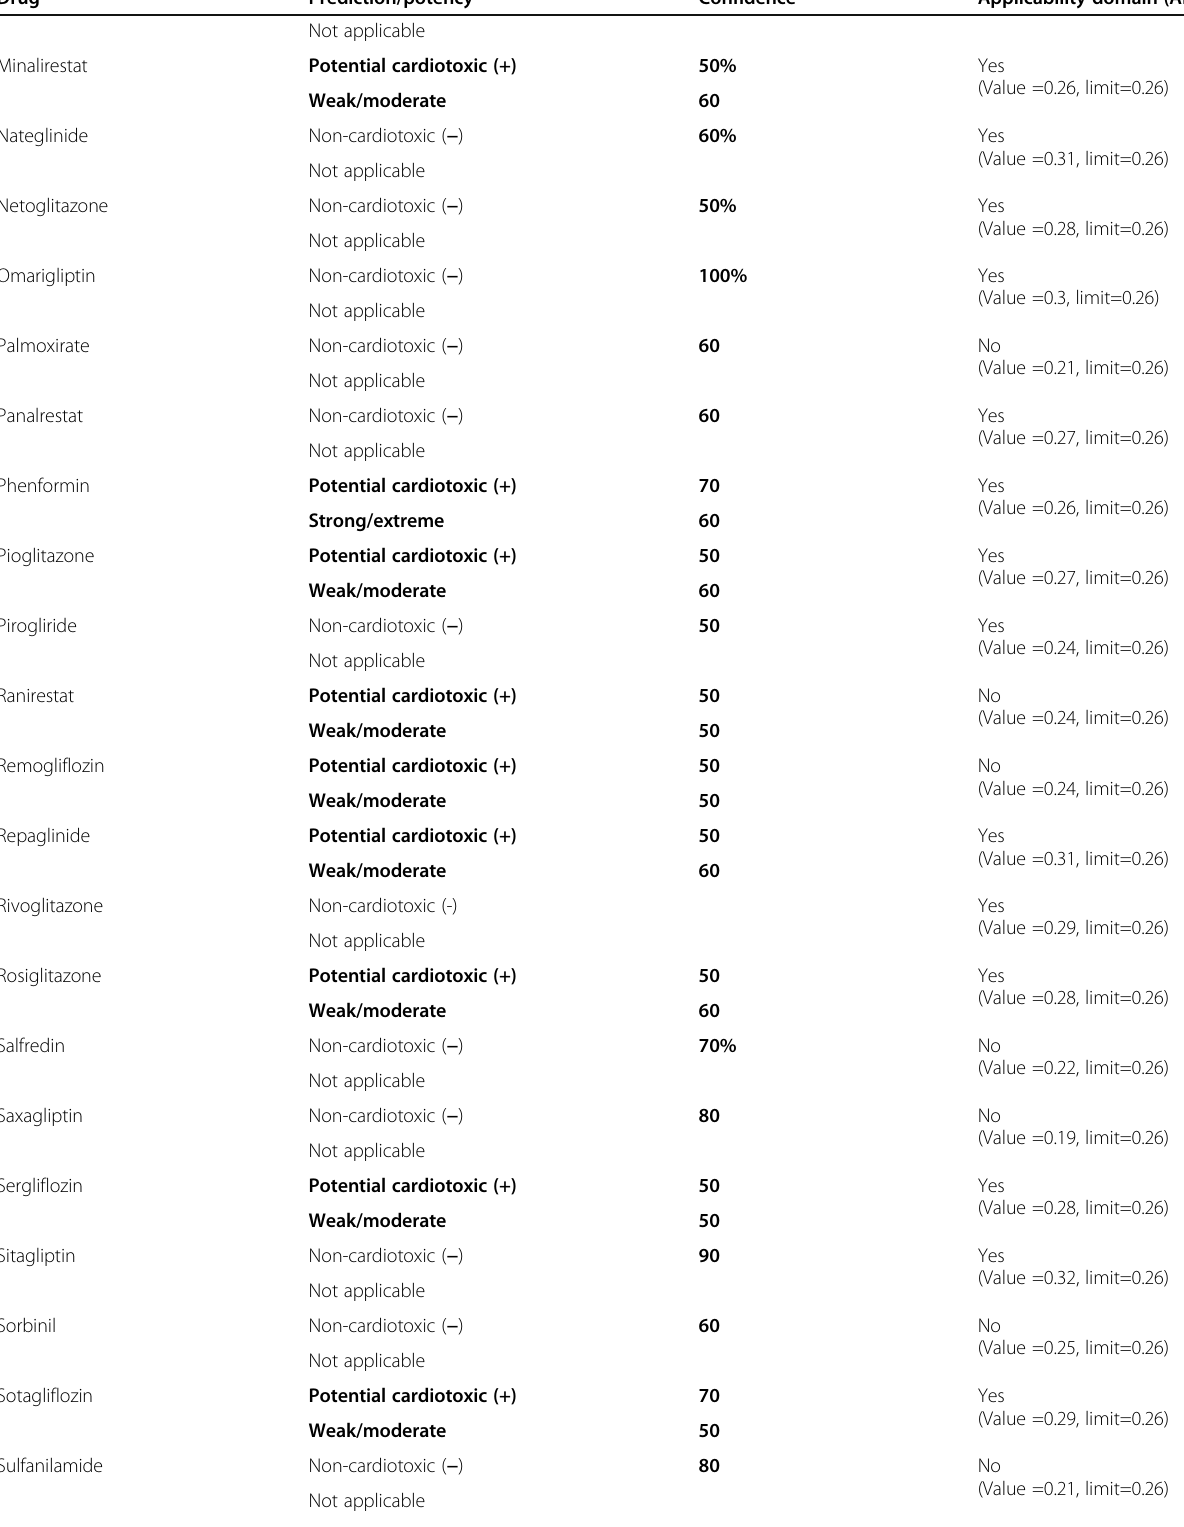
Table 1 Details of anti-diabetic compounds selected for study and their hERG blocking profile (Continued)